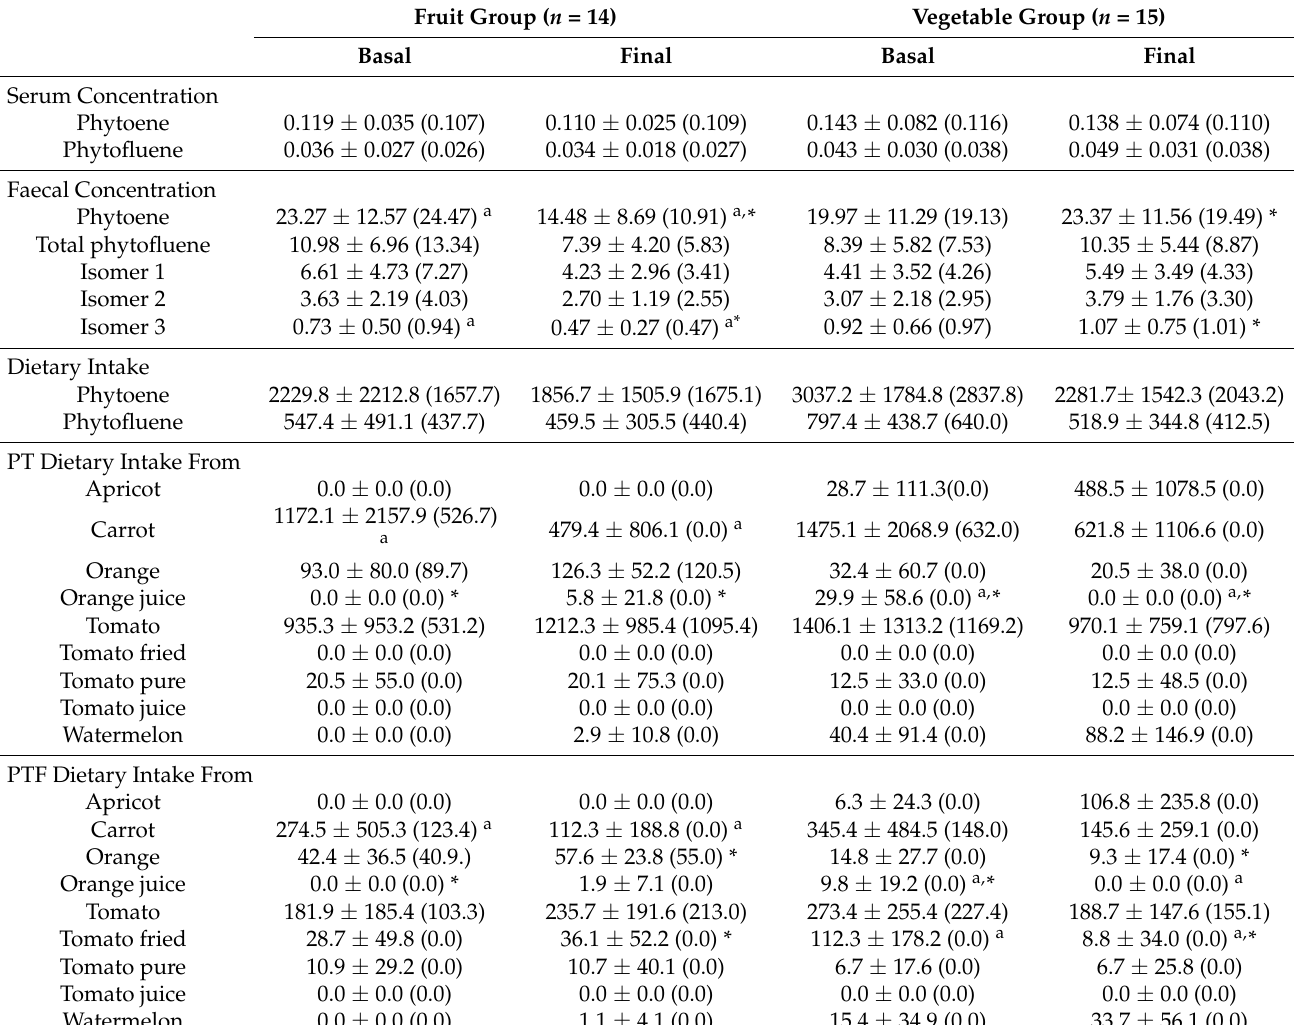
Table 2. Phytoene and phytofluene concentrations in serum ( µ mol/L), faeces ( µ g/g dry weight) and dietary intake from major contributors to their dietary intake ( µ g/day) in the intervention study (Mean ± SD